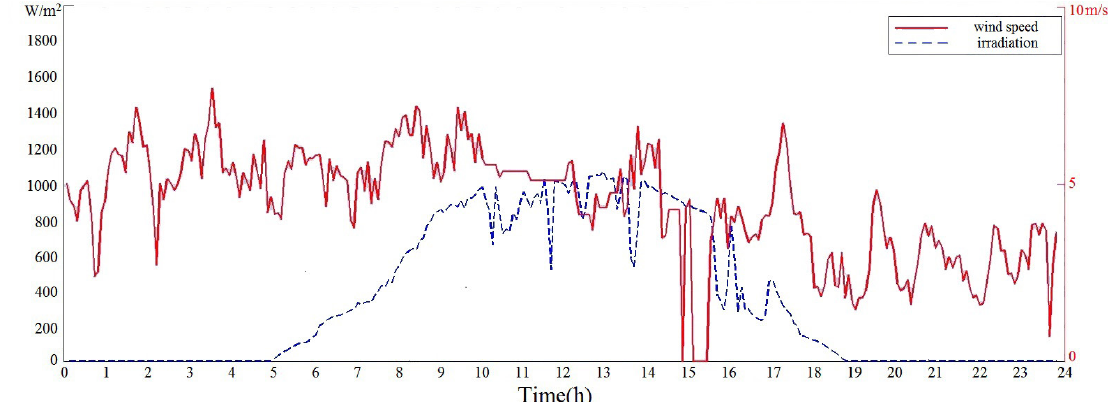
Figure 9. One day irradiation in